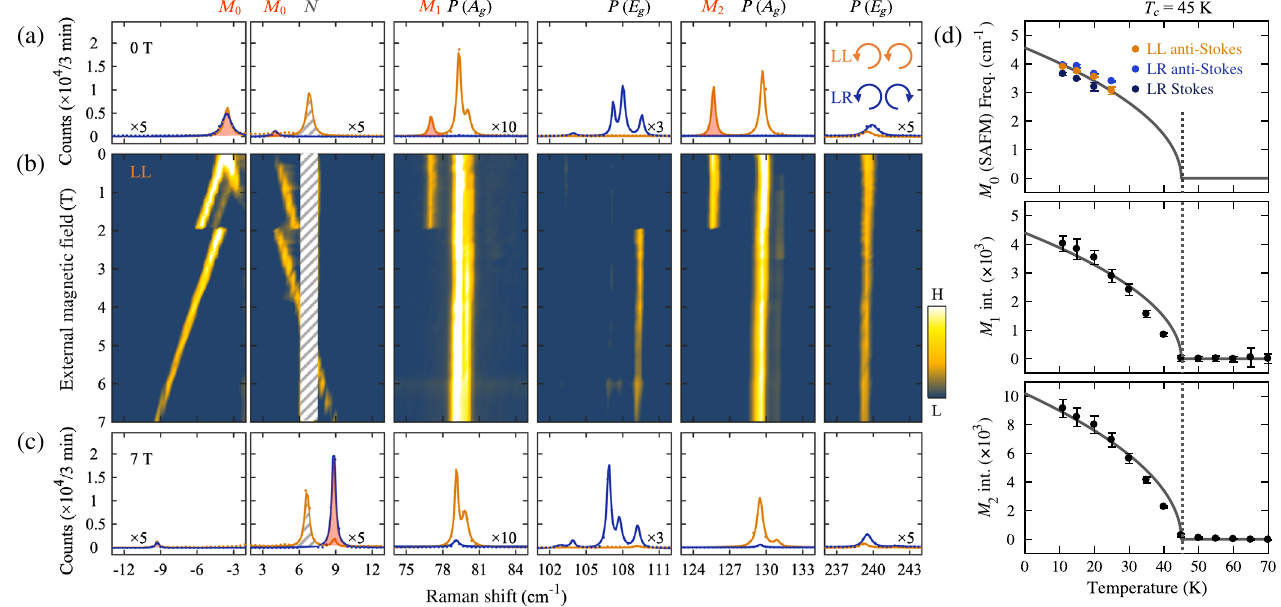
FIG. 1. Identifying the magnetism-related Raman modes in 3D CrI 3 . (a) Raman spectra taken at 10 K and 0 T in the LL and LR channels. LL(R) stands for the polarization channel in which the incident and scattered light is left and left (right) circularly polarized, respectively. Solid dots are raw data points and solid lines are Lorentzian fits. The multiplication factors to the spectra intensities are labeled in the corresponding panels. The Raman modes are labeled as M 0 for the magnetism-related ones (shaded in orange), P ð A ; 1 ; 2 phonon modes of the A and E symmetries of the C 3 point group, respectively, and N for the noise line from the incident light (shaded in g g i gray stripes). Inset shows the legends for the polarization channels. (b) A color map of magnetic field-dependent Raman spectra taken over a magnetic field range of 0 – 7 Tat 10 K in the LL channel. The gray stripe-patterned shade is to block the noise line. (c) Raman spectra taken at 10 K and 7 T in the LL and LR channels. (d) Temperature dependence of the M 0 frequency (including data for the LL anti-Stokes, LR anti-Stokes, and Stokes shifts) and M 1 intensities at zero magnetic field ( B ¼ 0 T) showing a clear onset at T ; 2 defined as one standard error of the fitting parameters in the Lorentzian fit to the Raman